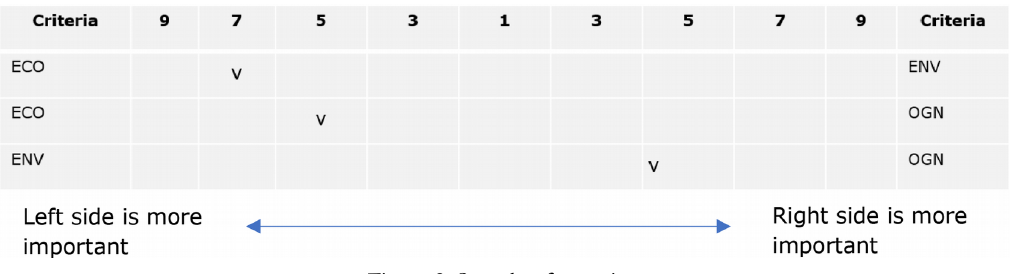
Figure 2. Sample of question